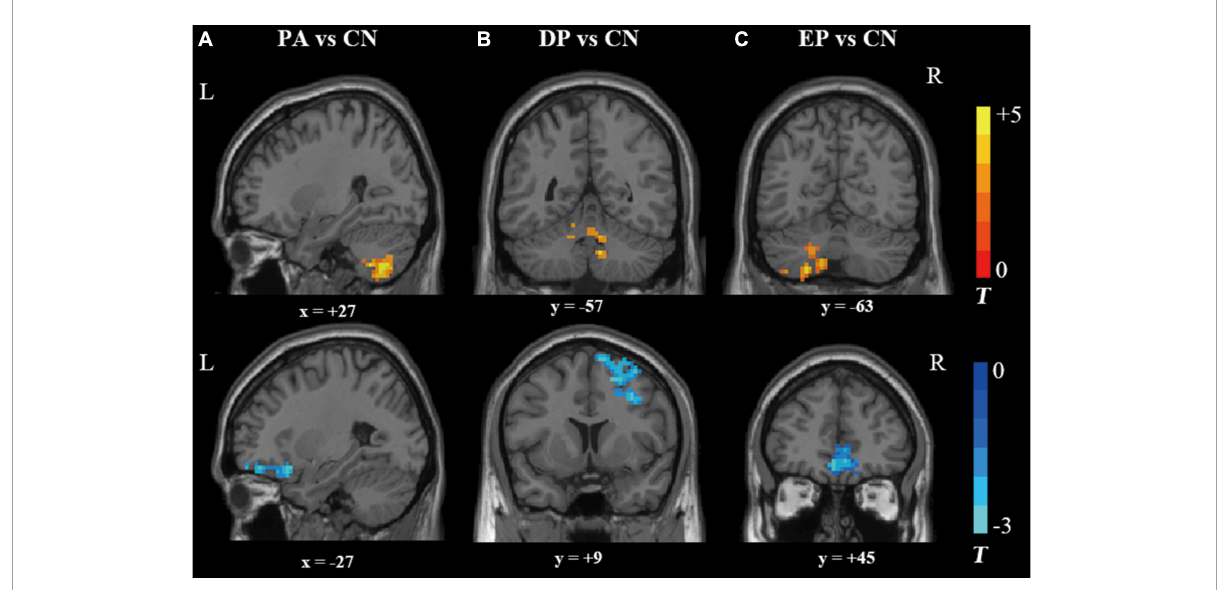
p -value DP EP CN ( N = 37) ( N = 21) ( N = 16) ( N = 23) PA vs. CN DP vs. CN EP vs. CN DP vs.